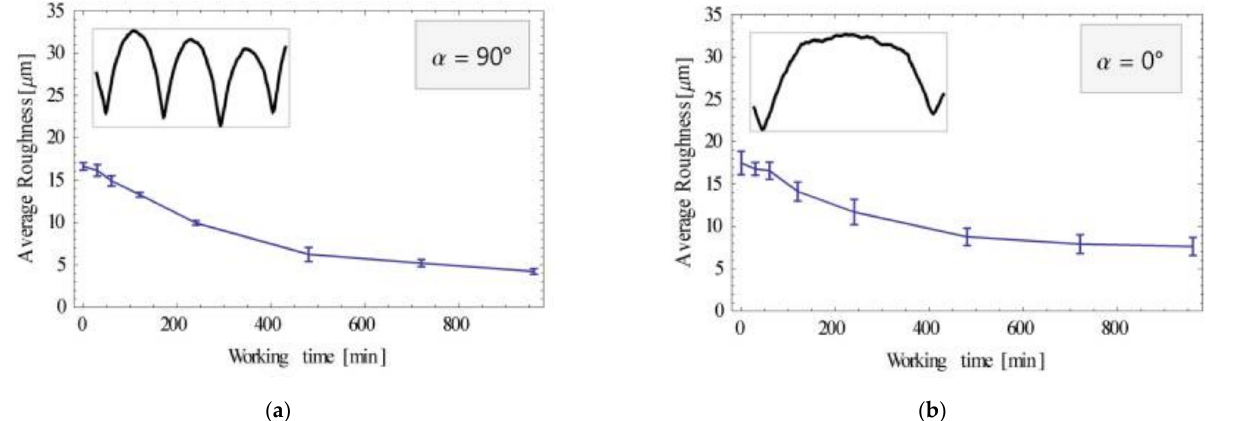
Figure 4. Surface roughness with the indication of the initial peaks as the function of time for: ( a ) the deposition angle α = 90 and ( b ) the deposition angle α = 0 [16].